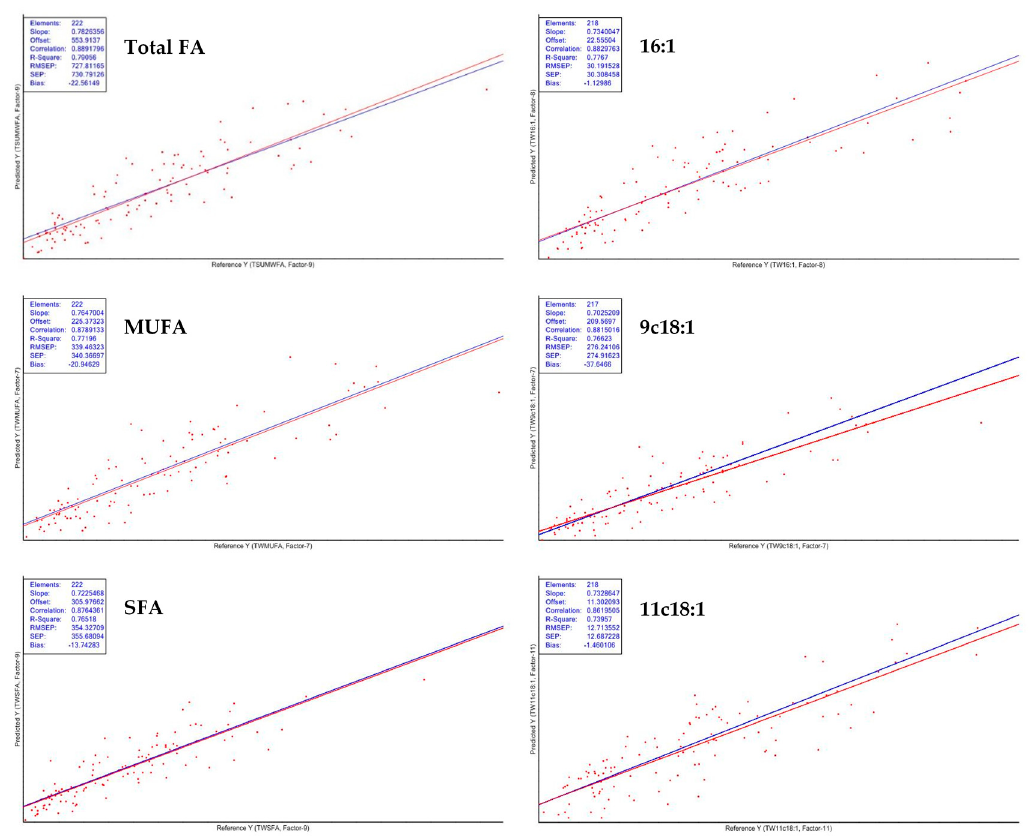
Figure 3. Scatter plots of models of 16:1, 11c18:1, total FA, SFA and MUFA of the total